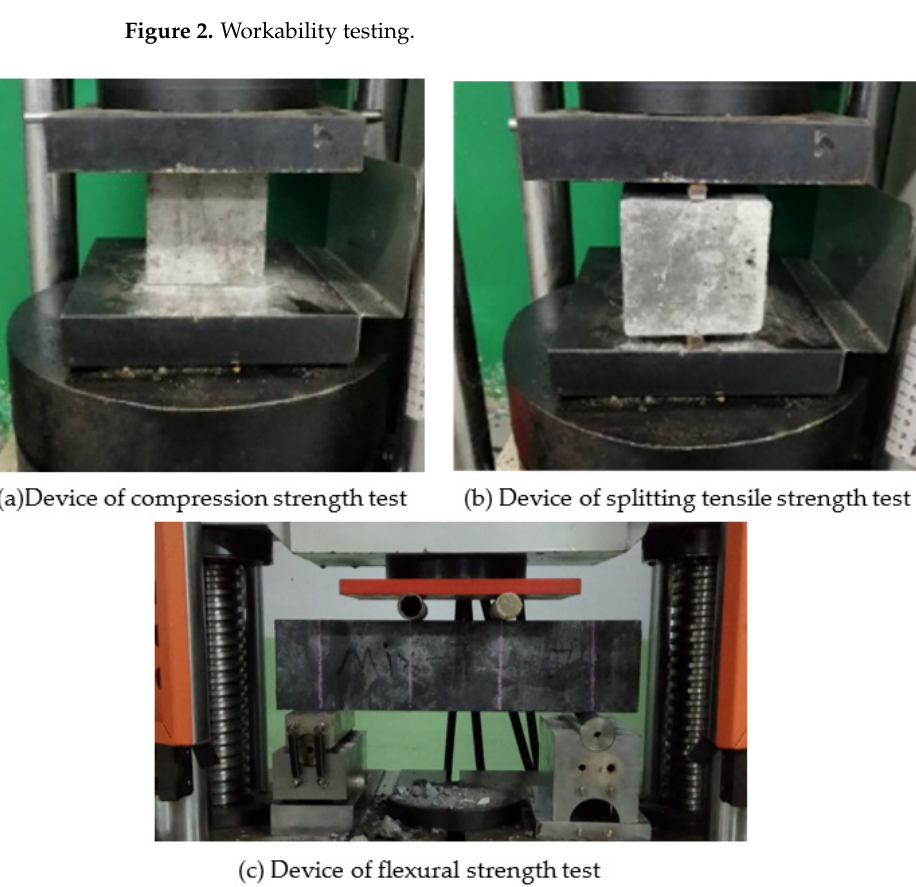
Figure 3. Device used for mechanical properties test.